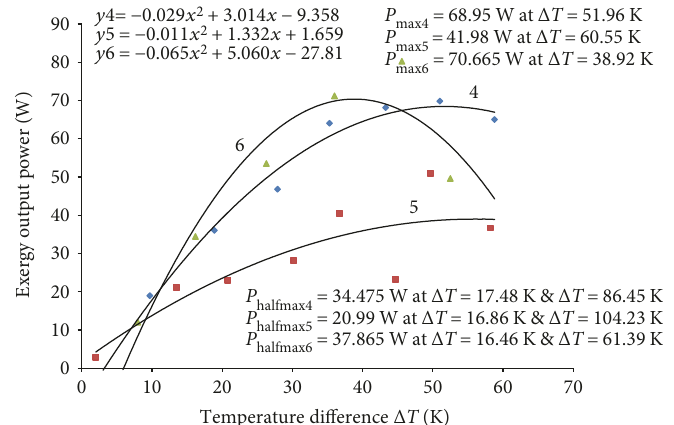
Figure 21: Exergy output power versus the temperature di ff erence. Data are fi tted with second order polynomials. Curves are labeled according to the experiment number.